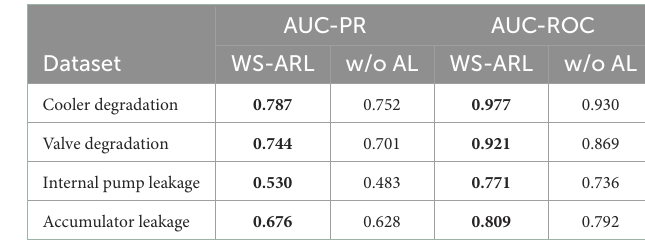
TABLE 3 Ablation experiments on four